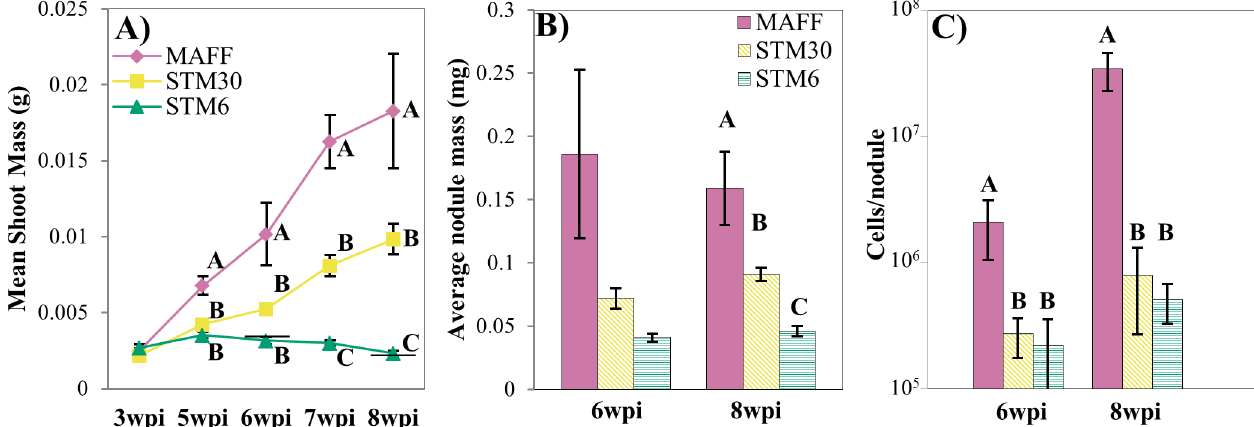
Fig 1. Traits of host and symbiont in growth chamberexperiment. L . japonicus hosts were inoculated with near-isogenic M . loti strains MAFF, STM30, and STM6 and host and symbiont phenotypeswere measuredat times indicated. ( A) Symbiont effectiveness was measuredas dried shoot biomass. ( B) Host investmentin symbionts was measuredas averageindividualbiomass of nodules(dry weight). ( C) Rhizobialfitness was estimated basedon CFUs from serially diluted extracts of crushed nodules. Error bars indicate one standarderror from the mean. Horizontal lines (A) represent the mean dried shoot biomass for uninoculated controls at 6 (0.003g)and 8wpi (0.002g). Data points demarkedwith different letters indicatesignificantdifferencesbetweenstrains at a given wpi. (one-way ANOVA, post-hoc Student’s t-test, α = 0.05).